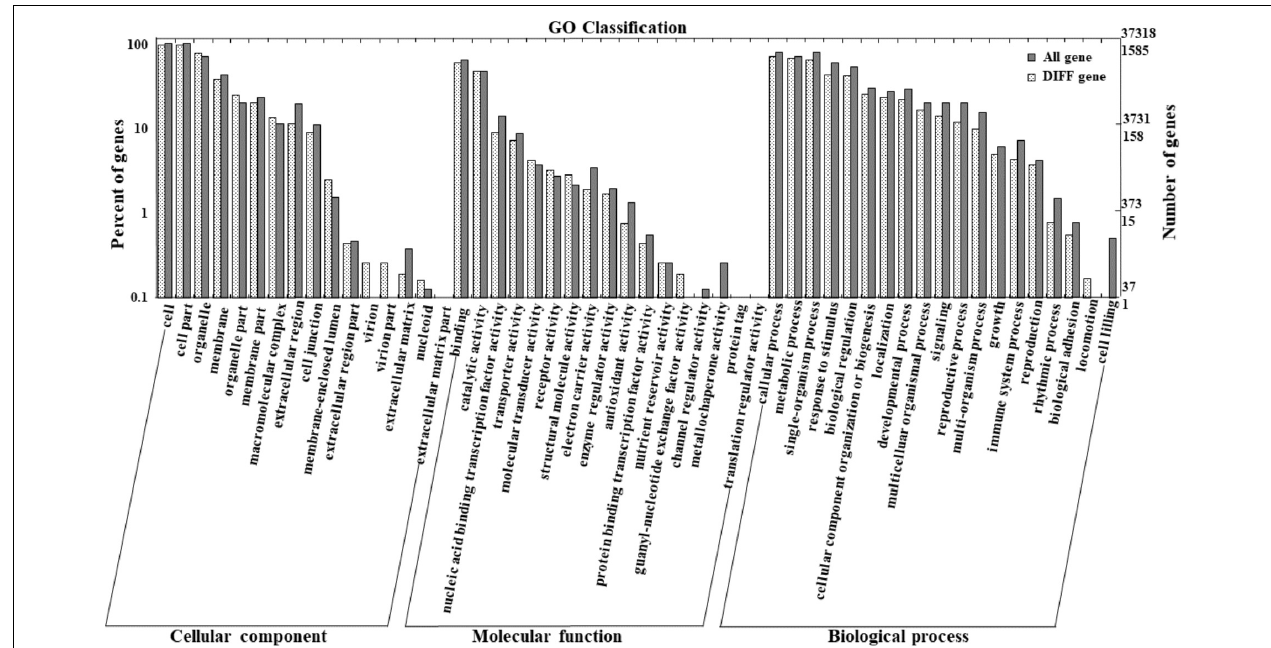
FIGURE 4 | Functional Classification of the DEGs by Gene Ontology (GO) Enrichment Analysis. RNA was extracted from the BrAN3 -silencing leaves with the empty vector pTY-S-inoculated leaves as the control at 60 days post inoculation (DPI), and used for library construction and RNA-Seq analysis. GO enrichment analysis of the DEGs was implemented by the GOseq R packages based on the Wallenius non-central hyper-geometric distribution (Young et al., 2010), which allows the adjustment for gene length bias in DEGs. It assigned all the genes and the DEGs to the three GO categories: biological processes, cell components, and molecular